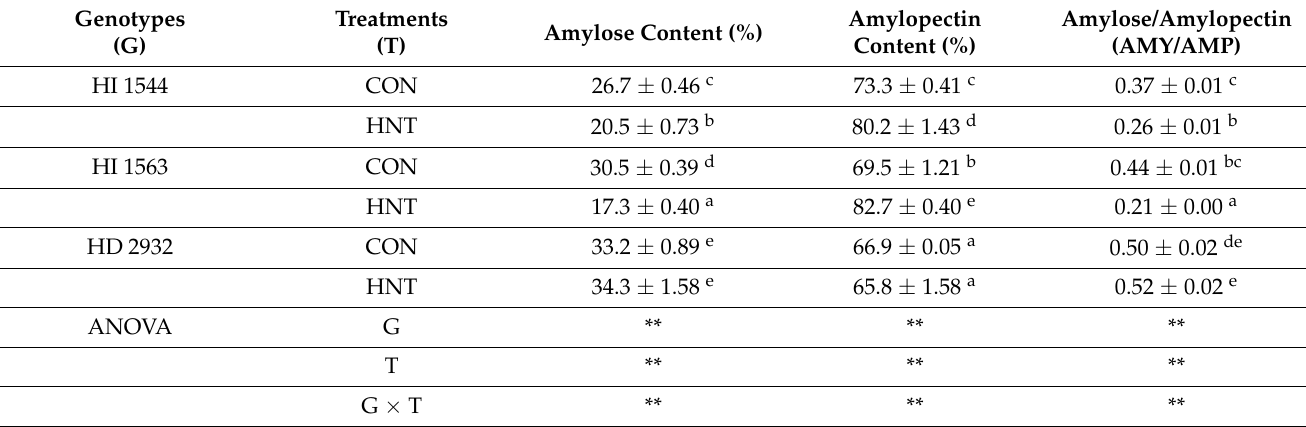
Table 4. Amylose and amylopectin content and their ratios in the grain of wheat genotypes grown under control and HNT conditions at 20 DAA. Values show mean ± SE. Data were obtained from three replications of each genotype. The separation of means was carried out using Duncan’s post hoc test ( p < 0.05). Means with different letters are significant. ** p < 0.01.